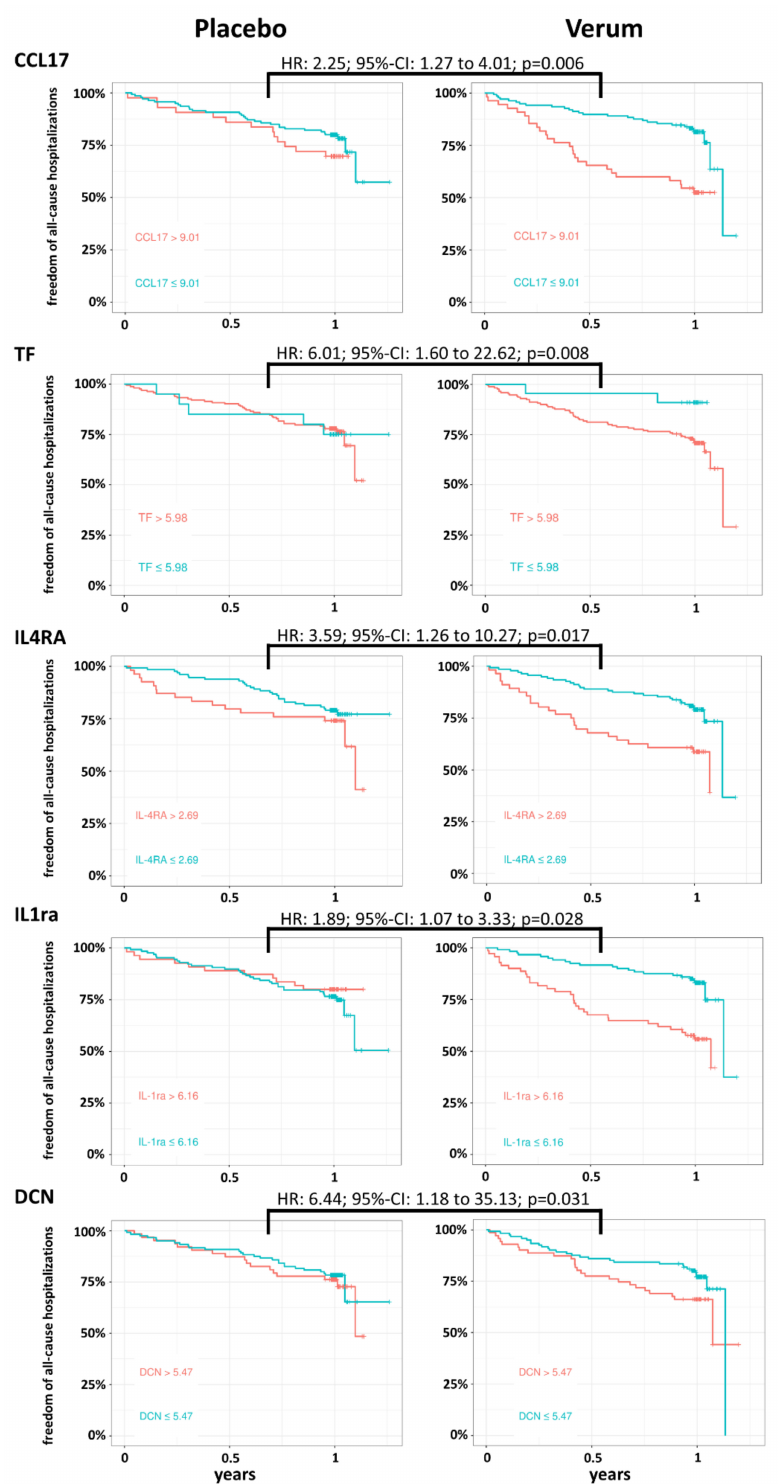
Figure 3. Plasma biomarkers with predictive value regarding spironolactone-mediated effects on all-cause hospitalizations in HFpEF patients. Based on data from the Cox proportional-hazards model (corrected for age and sex), Kaplan–Meier curves per study arm (spironolactone/verum vs. placebo) for the proteins with significant associations with the time-to-first-hospitalization are shown. For visualization purposes, the protein values are binarized at the cut-off of the respective BL expression level that maximizes the standardized log-rank statistic. The text annotation gives the hazards ratio (HR) with 95% CI and p -value of the interaction effect of BL expression and study